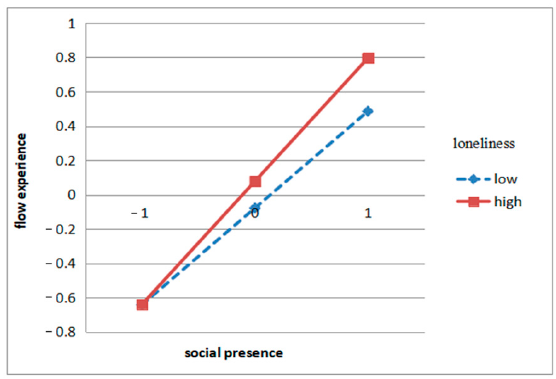
Figure 4. Interaction effects of loneliness and social presence on flow experience. Int. J. Environ. Res. Public Health 2020 , 17 , x